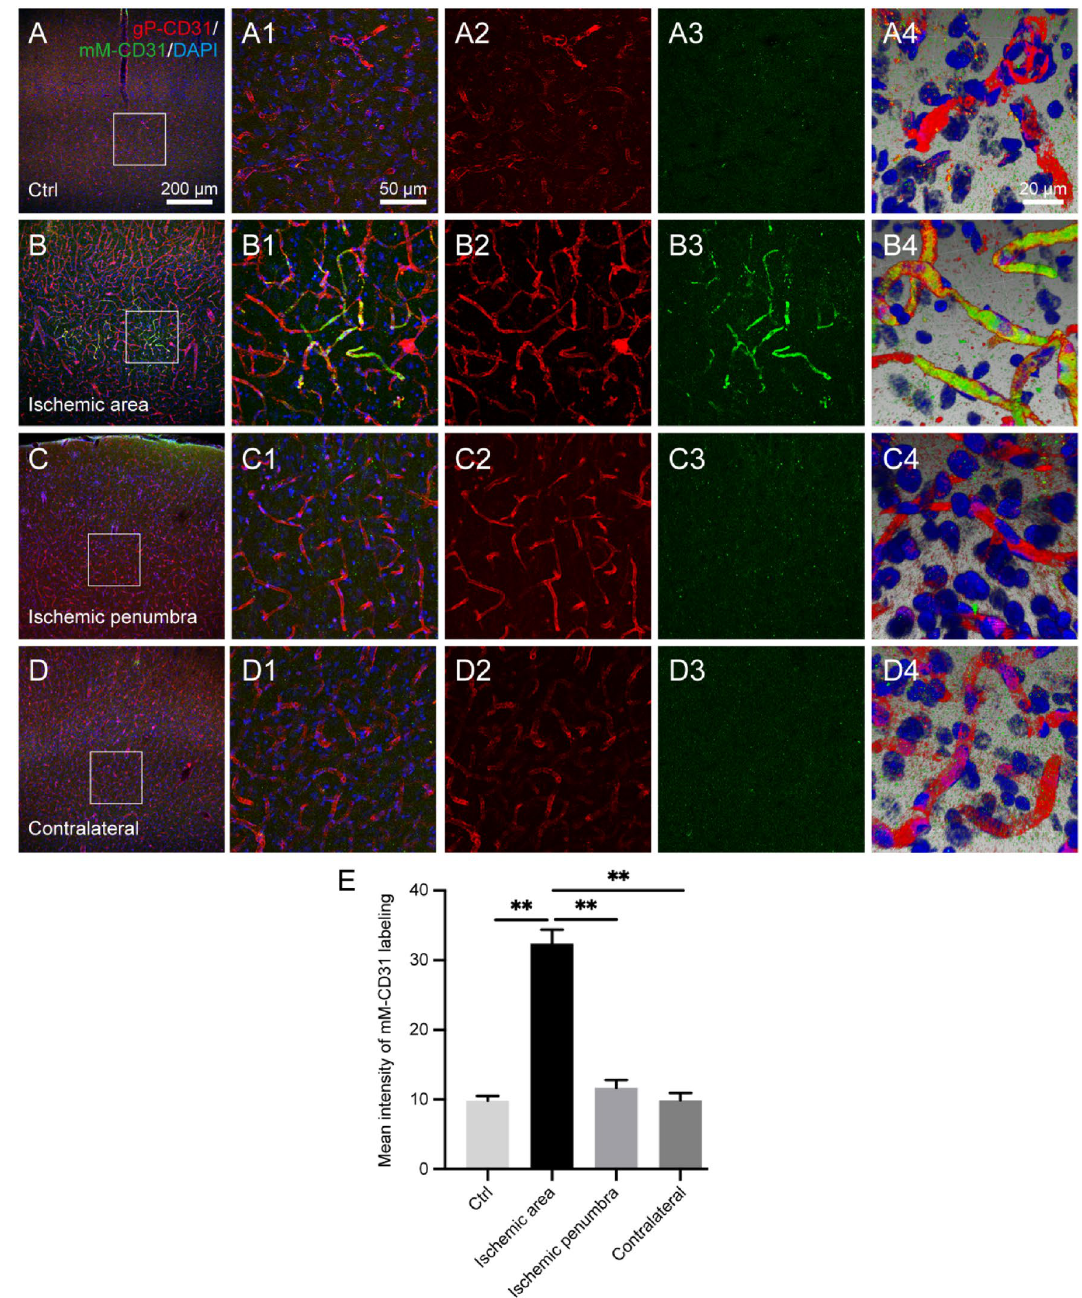
Figure 4. Comparing the distribution of cortical vascular labeling between goat polyclonal anti-CD31 (gP- CD31) and mouse monoclonal anti-CD31 (mM-CD31) in the healthy and ischemia/reperfusion rat brains. ( A – D ) Representative photographs from the cerebral cortex showing the difference of vascular labeling with gP-CD31 (red) and mM-CD31 (green) antibodies, including the normal region ( A ), ischemic region ( B ), ischemic penumbra ( C ), and matching contralateral region ( D ). ( A1 – D1 ), ( A2 – D2 ), ( A3 – D3 ) Corresponding magnified photographs from panels ( A – D ) (box-indicated regions) showing the detailed vascular labeling ( A1 – D1 ) separately with gP-CD31 ( A2 – D2 ) and mM-CD31 ( A3 – D3 ), and further adjusted with three-dimensional reconstruction showing the spatial relationship of vascular labeling with gP-CD31 and mM-CD31 in